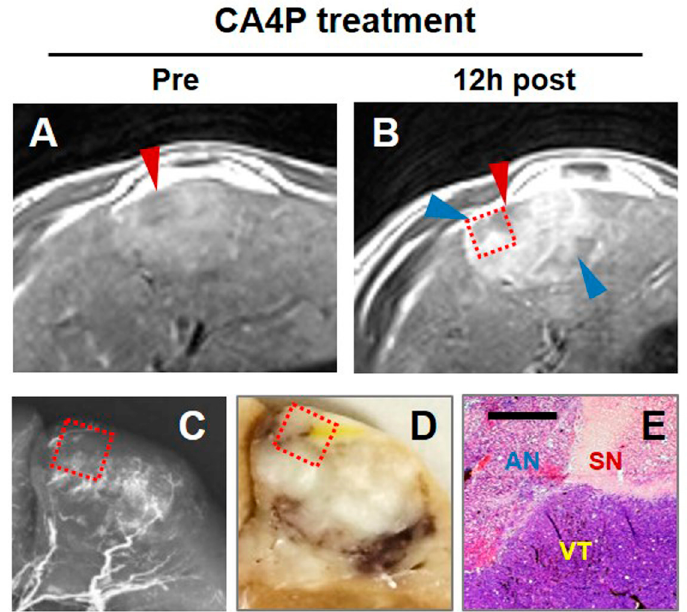
Figure 4. Differentiating chronic spontaneous necrosis (SN) from CA4P induced acute necrosis (AN) in an HCC. ( A ): Tumor SN (red arrowhead) existing before CA4P treatment appeared unenhanced by Gd-DOTA on T1WI. ( B ): Twelve hours after treatment, more unenhanced regions suggests CA4P-induced AN (blue arrowheads). ( C ): On microangiogram, both types of necrosis showed absent vasculature. ( D ): On photomacrograph, SN looked yellowish in contrast to the adjacent CA4P-induced hemorrhagic AN. ( E ): On photomicrograph, SN was featured by sclerotic fibrous stroma and the hyalinized degeneration, while CA4P-induced AN was identified as cell rupture, hemorrhage and inflammatory infiltration (H&E staining, × 100 original magnification, scale bar = 100 µ m, VT: viable tumor).